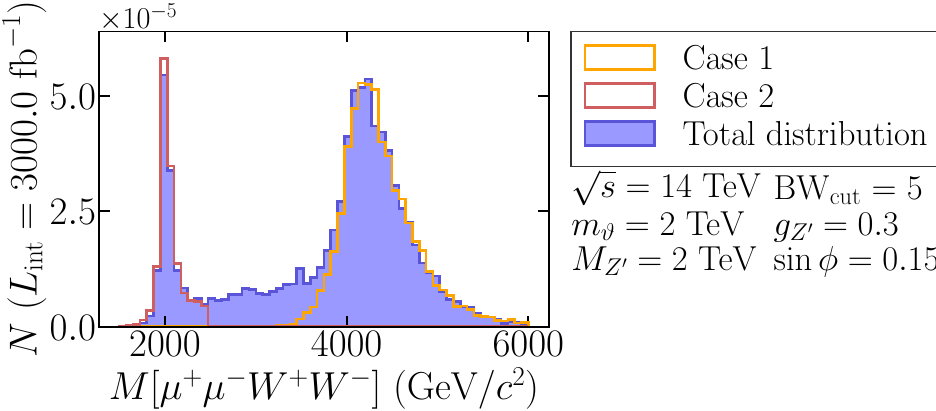
Figure 8. Illustration of the two resonant contributions to the flavonstrahlung cross-section for the leading µ + µ − W + W − final state. The blue region shows the final state invariant mass distribution in the absence of SM backgrounds at the 14 TeV HL-LHC. The orange curve delineates the contribution arising from case 1, where the second Z 0 in figure 7 is on-shell, whereas the red curve corresponds to case 2, where the first Z 0 is